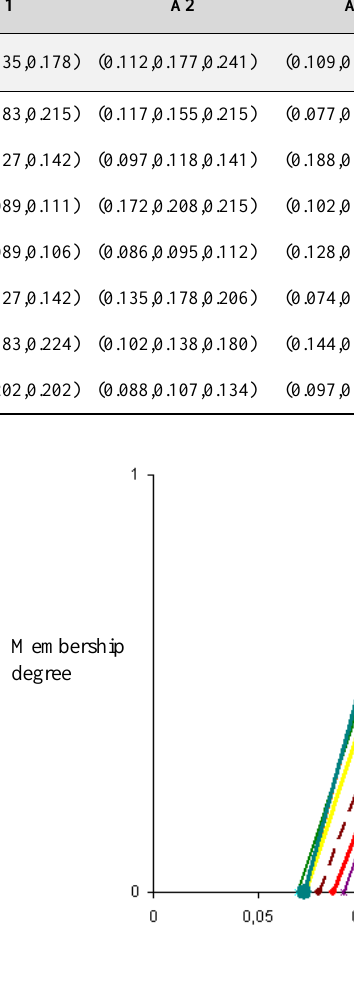
Figure 2. Global fuzzy weights of the risks obtained by the modified fuzzy